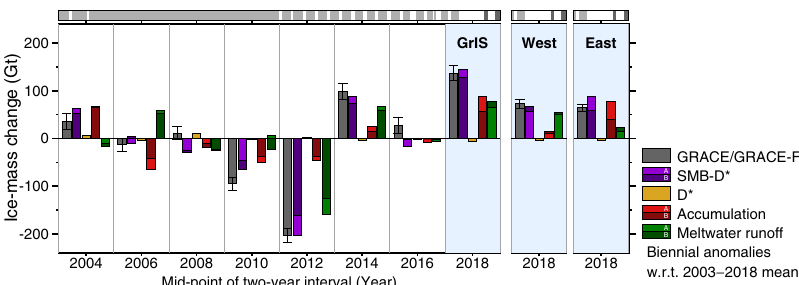
Fig. 2 Biennial mass balance anomalies and individual components for the Greenland Ice Sheet between 2003 and 2019. Shown are anomalies of the biennial mass balance from GRACE/GRACE-FO, with 2- σ error bars, and SMB-D* along with the components of accumulation, meltwater runoff and solid ice discharge (D*), with respect to their corresponding 2003 – 2018 mean values. For GRACE/GRACE-FO the 2003 – 2018 mean is − 235 ± 29 Gt year − 1 . Shown are results for MARv3.10 (A) and RACMO2.3p2 (B). The period 2017 – 2018 stands out with the most positive mass loss anomaly of + 137 ± 25 Gt year − 1 , caused in equal parts by enhanced snowfall and reduced meltwater runoff in the eastern and western drainage basins, respectively 37 . The top bar indicates the availability of GRACE and GRACE-FO measurements.